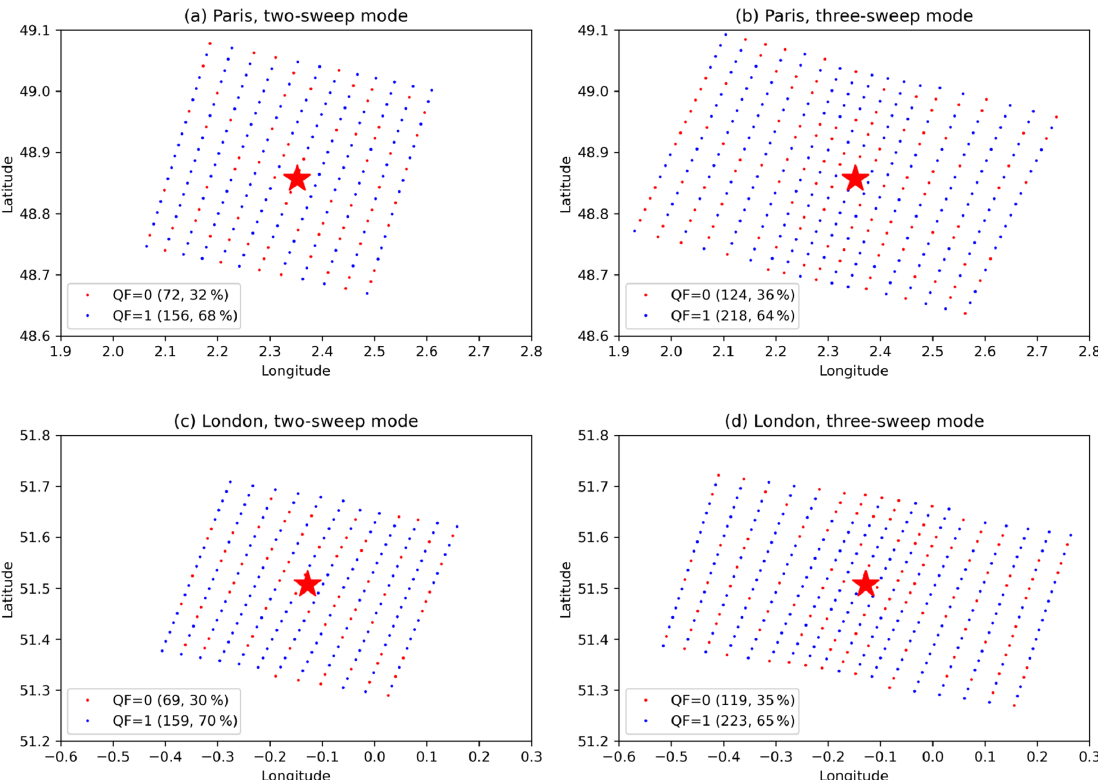
Figure 2. MicroCarb city-mode sampling patterns for the two-sweep and three-sweep modes in Paris (a, b) and London (c, d) . Samplings are marked by quality flag (QF) using ERA5 total cloud cover at 12:00UTC on 15 April 2018. QF = 0 means the samplings are cloud-free, and QF = 1 means the samplings are cloud-contaminated. Numbers in the parentheses are the number of observations and the percentage relative to the total number of observations for the two-sweep (228) and three-sweep (342) modes. The red star marks the city centre. The satellite moves from northeast to southwest, and wind comes from